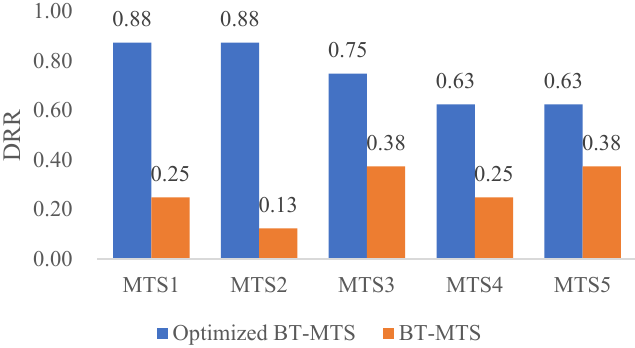
Figure 6. Comparison of DRR of the glass data set.